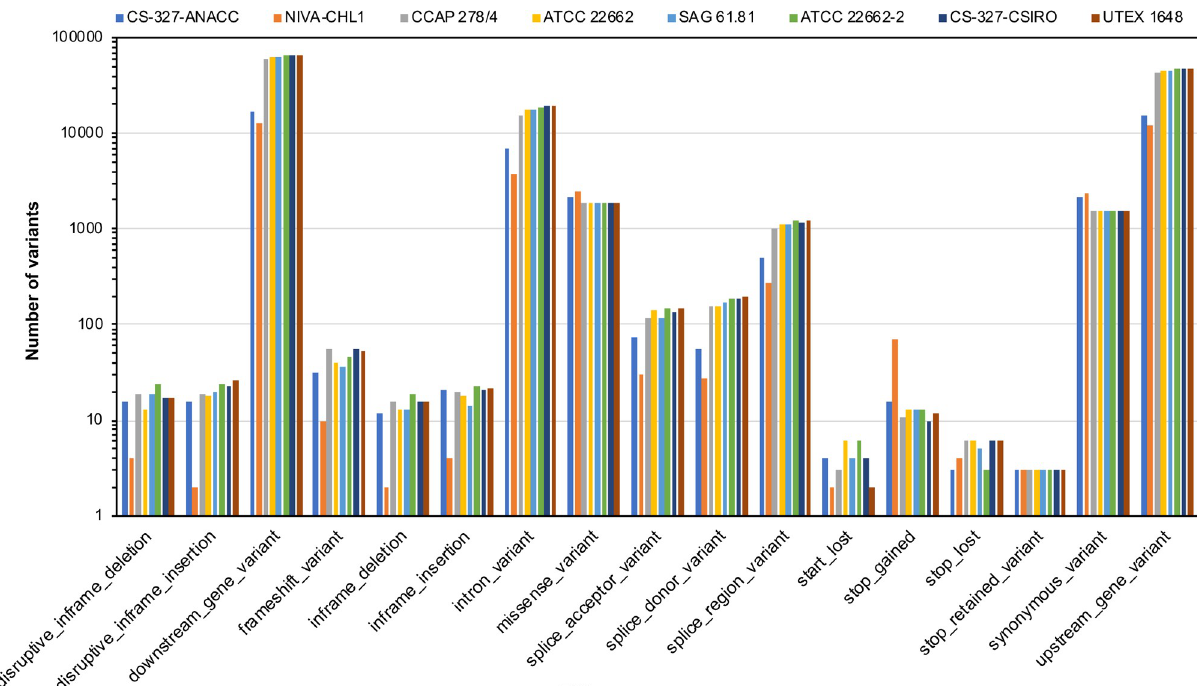
Fig 1. Categorization of each single-nucleotide polymorphism and indel by snpEff term. The terms are explained at http://snpeff.sourceforge.net/ snpEff_manual.html.